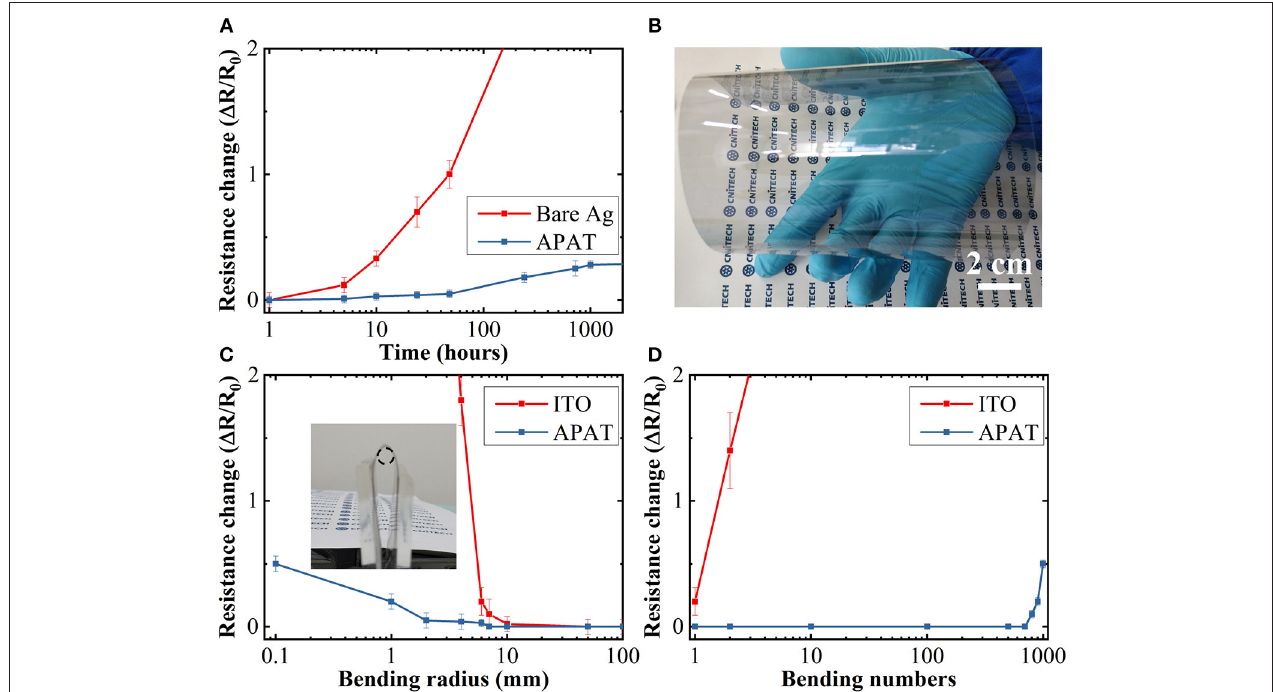
FIGURE 4 | (A) Relative changes in the resistance of bare Ag and APAT film as a function of exposure time of up to 1,000h. (B) Photograph of an 8 in flexible APAT film on PET. Relative change in the resistances of ITO and APAT films as a function of (C) bending radius and (D) number of bending cycles at a bending radius of 9mm. The inset in (C) shows a photograph of a folded APAT film with a bending radius of 2mm set for the bending